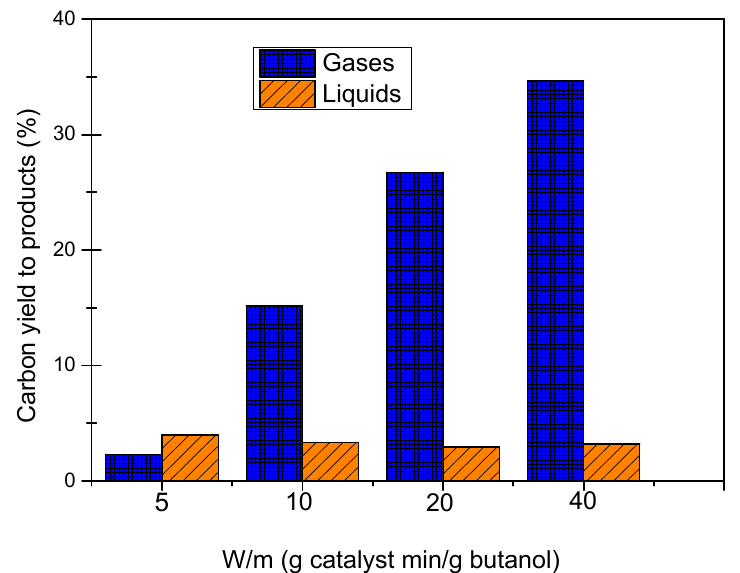
Figure 2. Carbon yield to gases and liquids in the APR of butanol at different catalyst loading (T = ◦ C, 40 bar, 5 wt% butanol, Ni-Co/Al-Mg catalyst, 1 mL/min aqueous feeding 227 °C, 40 bar, 5 wt% butanol, Ni-Co/Al-Mg catalyst, 1 mL/min aqueous feeding rate). (T = 227